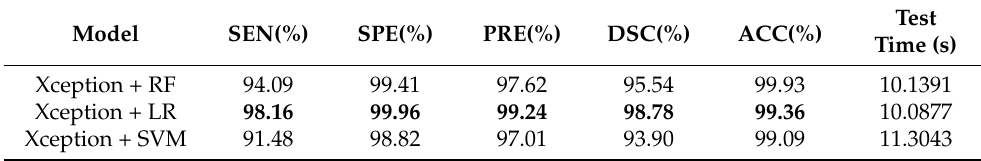
Table 9. The performance evaluation for Xception combined with different classifiers.